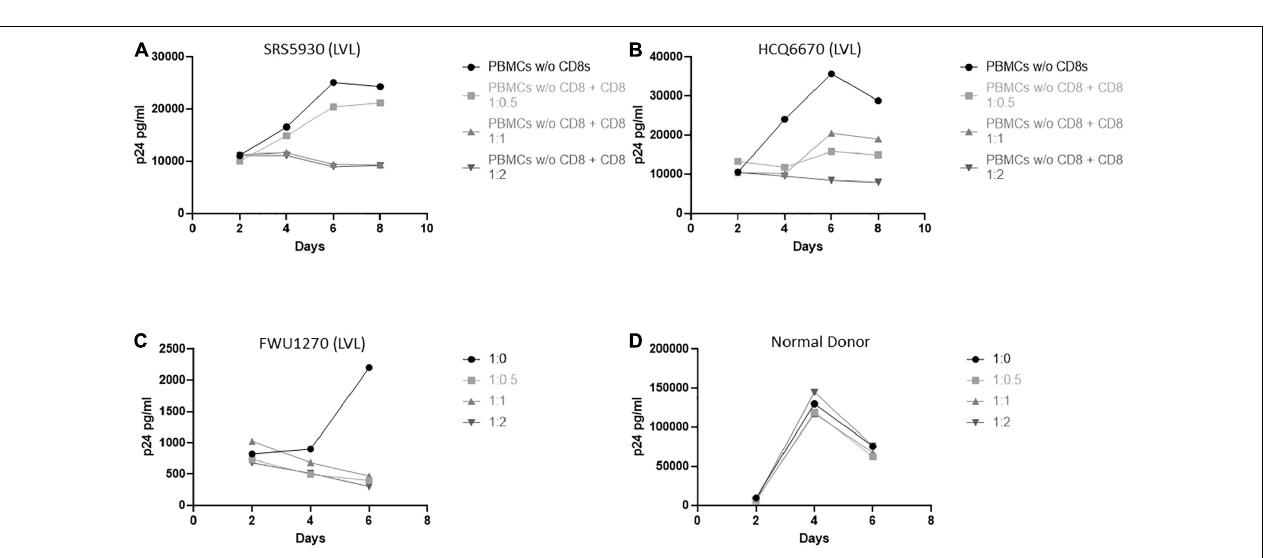
FIGURE 3 | CD8 + T-cells are necessary and sufficient for control of viral replication by LVLs in vitro. (A,B) CD8 + T-cells were depleted from PBMCs of two LVLs. Depleted PBMCs and CD8 + T-cells were then stimulated for 48 h with PHA and IL-2 before being combined at the indicated ratio of PBMC:CD8 and infected with NL4-3. Supernatant was collected every 48 h post infection and virus levels were determined by p24 ELISA. CD4 + and CD8 + T-cells were isolated from PBMCs from (C) an LVL or (D) a normal donor. Isolated T-cells were induced with PHA and IL-2, combined as above (CD4:CD8) then infected with NL4-3 48 h later. Supernatant was collected every 48 h post infection and virus levels were determined by p24 ELISA.